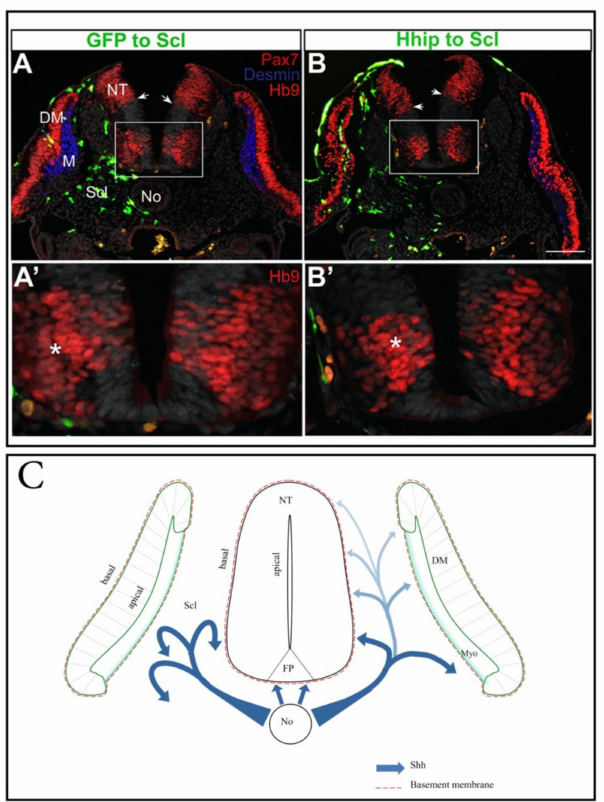
Figure 2. Notochord-derived Shh traversing the sclerotome affects both myotome and motoneuron differentiation. ( A , B ) Electroporation of control GFP (green) ( A ) or hedgehog-interacting protein (Hhip1) (green in ( B )) to the prospective sclerotome at the flank level of the axis. A day later a reduction in myotome size (blue desmin staining) is apparent adjacent to the transfected cells. In addition, note ventral shift of the Pax7+ boundary in ( B ) (small arrows) indicative of a dorsalization of NT properties. ( A’ , B’ ) Higher magnification of the insets in ( A , B ), respectively, depicting a reduction of Hb9+ motoneurons in ( B ) upon Hhip1 treatment compared to the control side and to control GFP ( A’ ). Asterisks (*) denote motoneurons adjacent to electroporated sclerotomes. Similar results were obtained with a membrane-tethered Hhip and with Ptc plasmids [see [188] for further details]. ( C ) A proposed model for the activity of notochord (No)-derived Shh. The No secretes Shh that acts on the ventral neural tube (NT) and also traverses the sclerotome (Scl) which is both a pathway for ligand movement and also a target of its activity. A ventral to dorsal gradient of ligand is created in Scl (blue arrows) [166], that influences both myotome as well as motoneuron development. Shh is thus presented to the target epithelial cells via its basal domain, probably by initial association with the laminin-containing basement membrane (red line). In addition, Shh traversing the sclerotome is also required for aspects of sclerotomal development (blue arrows on left side of image). Scale Bar, 50 µ